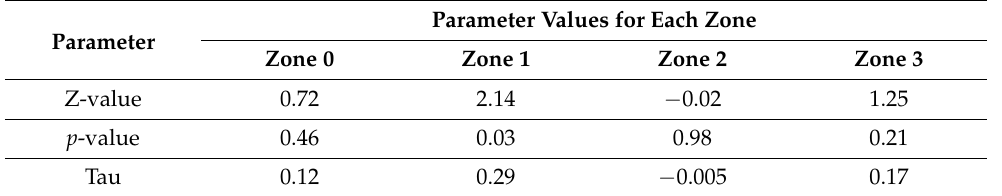
Table 11. Mann-Kendall Trend Test When Combined Criteria are